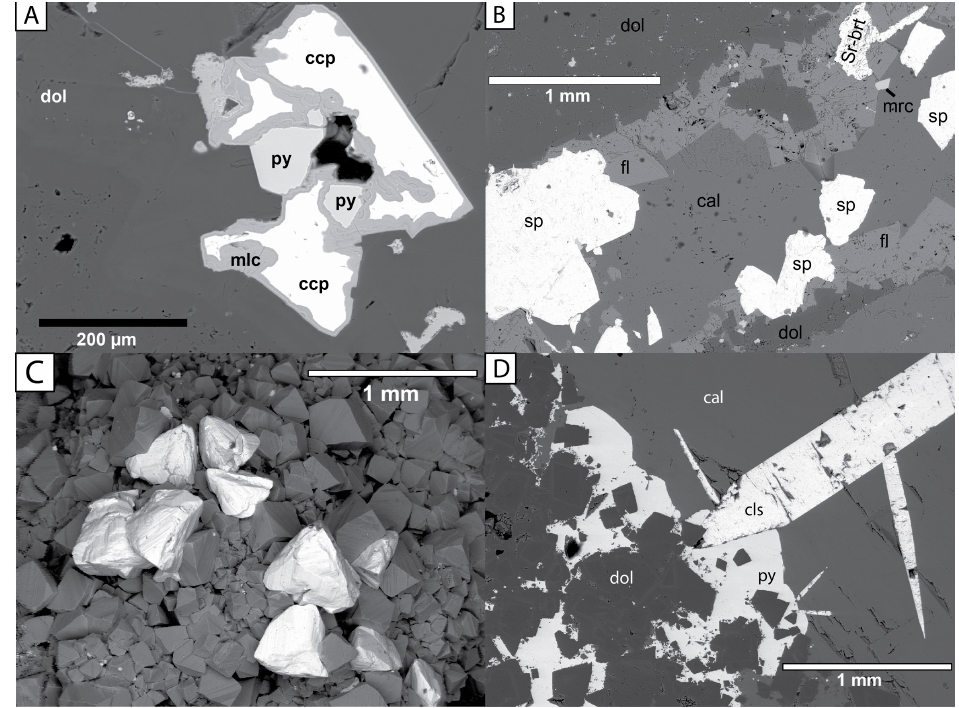
Figure 9. SEM-BSE images of Cu, Cr, Sr, and Ba-bearing minerals from the study area: ( A ) polished thin section from Locality 46 in the Oneota Formation (lower Prairie du Chien Group) of western Outagamie County; ( B ) highly variable mineralogy in a few millimeter-wide fracture from Locality 33 in Menominee County, Michigan; ( C ) chalcopyrite (bright) on dolomite (gray) from Locality 39 in Oconto County; and ( D ) an assemblage of dolomite, celestine, pyrite and late calcite from the Platteville Formation at Locality 3 in Brown County. Labeled minerals are dolomite (dol), calcite (cal), botryoidal malachite (mlc), pyrite (py), chalcopyrite (ccp), sphalerite (sp), strontium-barite (Sr-brt), marcasite (mrc), fluorite (fl), and celestine (cls).